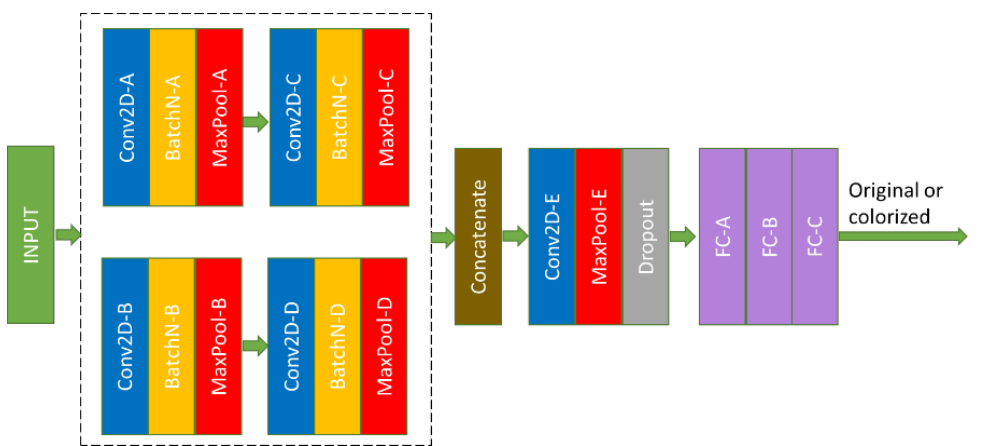
Figure 2. The proposed architecture. Conv is convolutional layer; BatchN is batch normalization; MaxPool is max-pooling; FC is the fully-connected layer. Table 1. Summary of the proposed custom architecture for the classification of colorized images.